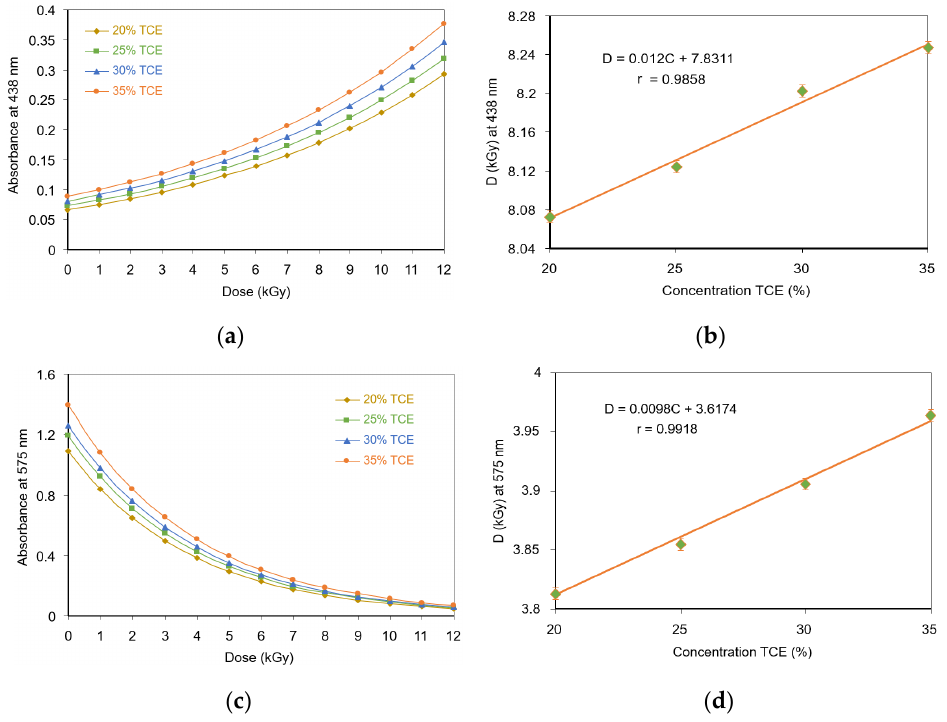
Figure 6. Optical absorption dose response; ( a ) dose response curve at 438 nm band; ( b ) sensitive dose D 0 vs. TCE composition as derived from 438 nm band; ( c ) dose response curve at 575 nm band; ( d ) sensitive dose D 0 as a function of TCE composition as derived from 575 nm band.